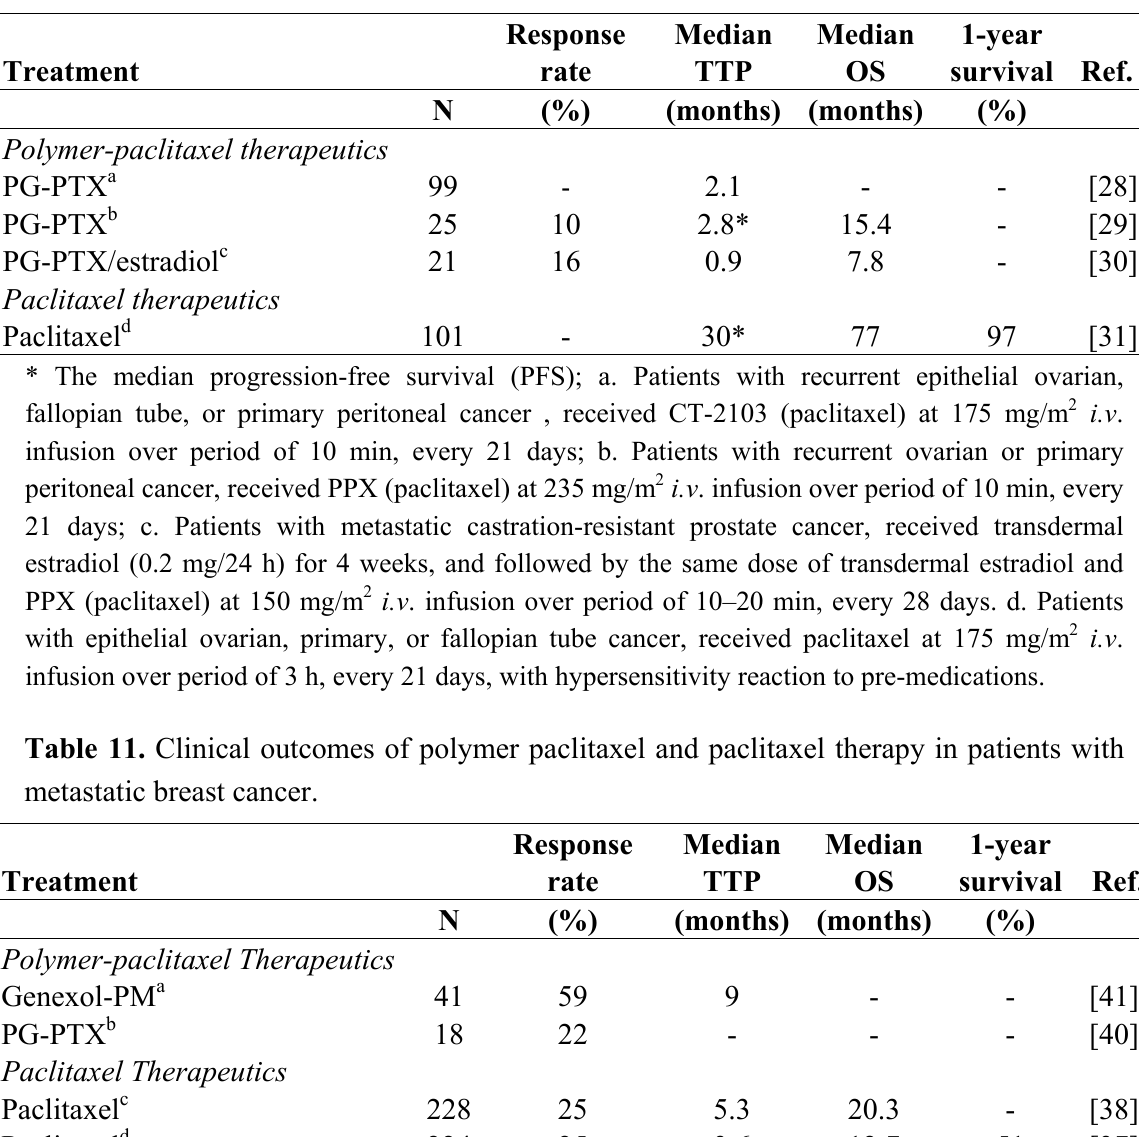
Table 10. Clinical outcomes of PG-PTX and paclitaxel therapy in patients with metastatic castration-resistant prostate, recurrent epithelial ovarian, fallopian tube, or primary peritoneal carcinoma.